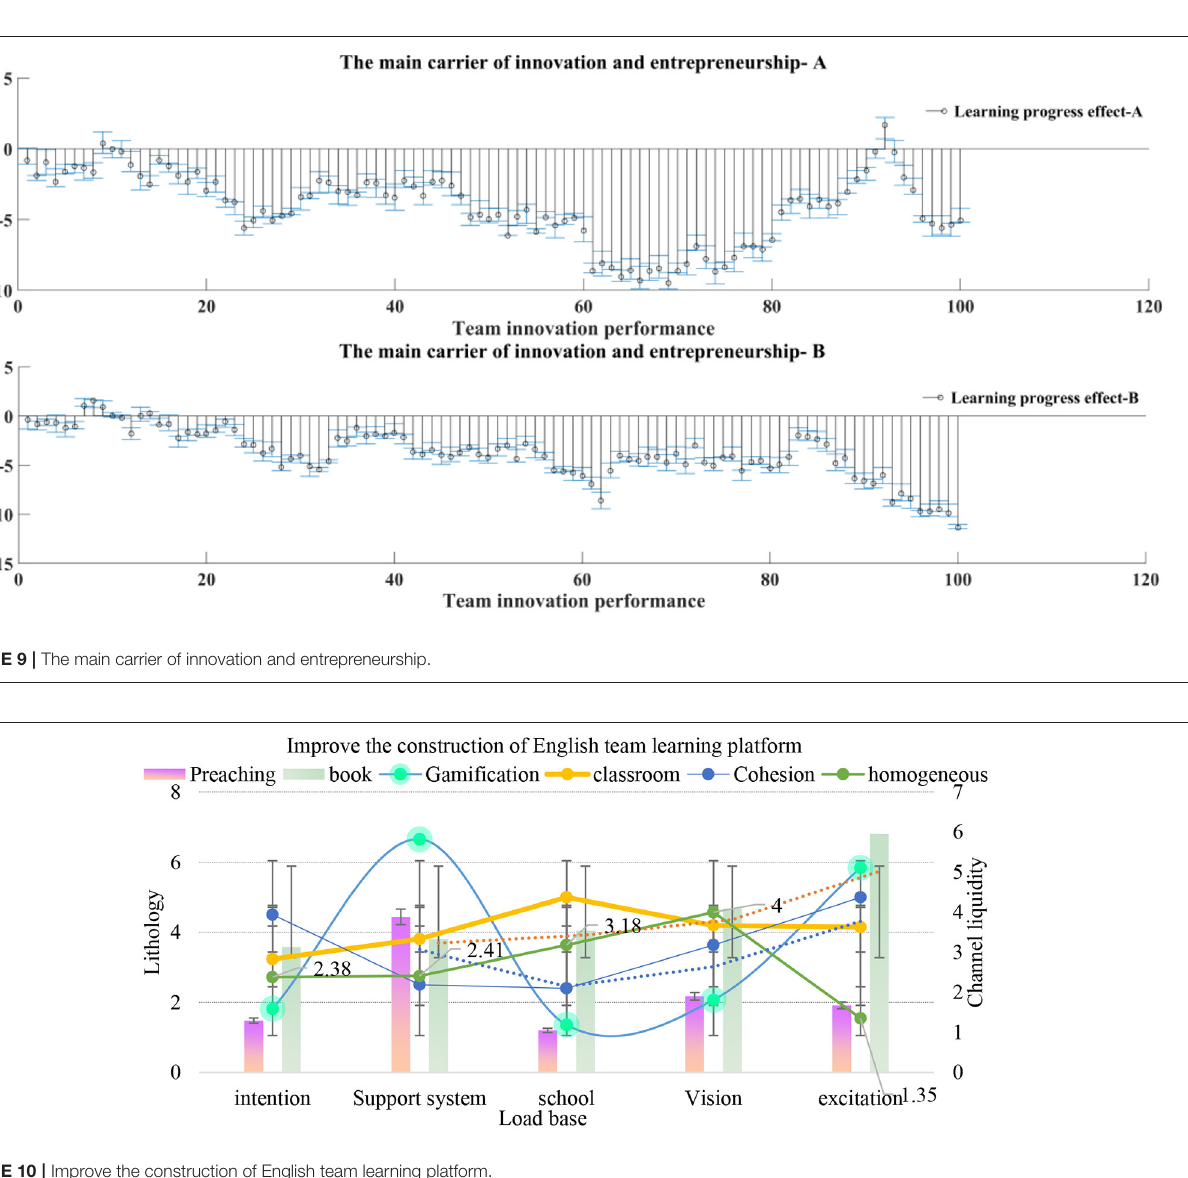
FIGURE 10 | Improve the construction of English team learning platform.